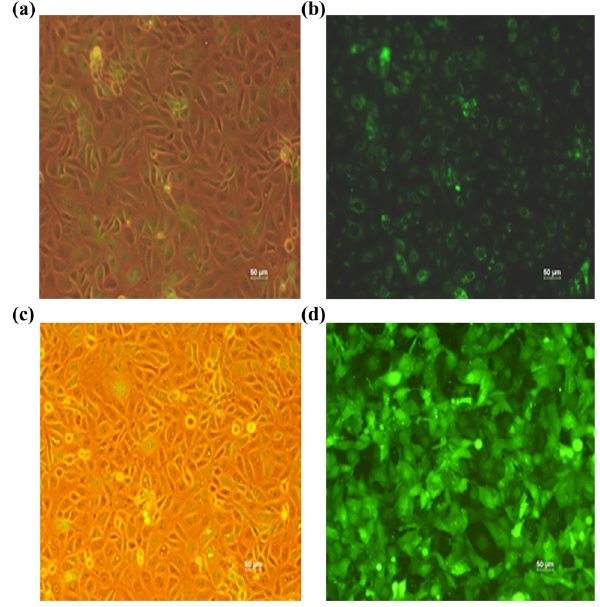
Figure 1: Stable infection of HK - 2 cells. ( a ) Hk - 2 cells under no fl uorescence microscope. ( b ) The GFP - RAB7 lentiviral vector